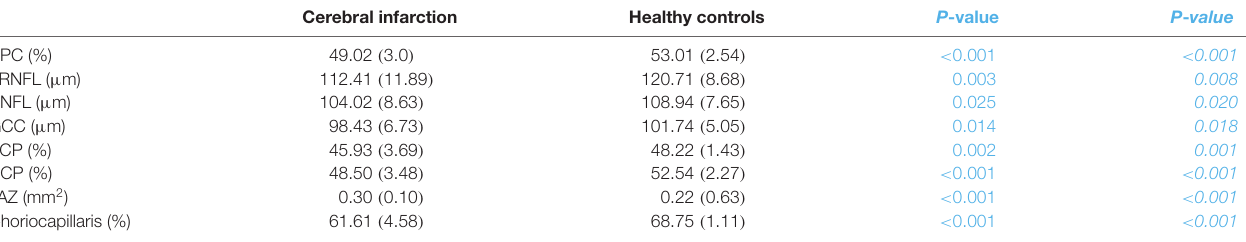
TABLE 2 | Comparison of the macula and choriocapillaris between cerebral infarction and healthy controls. Cerebral infarction